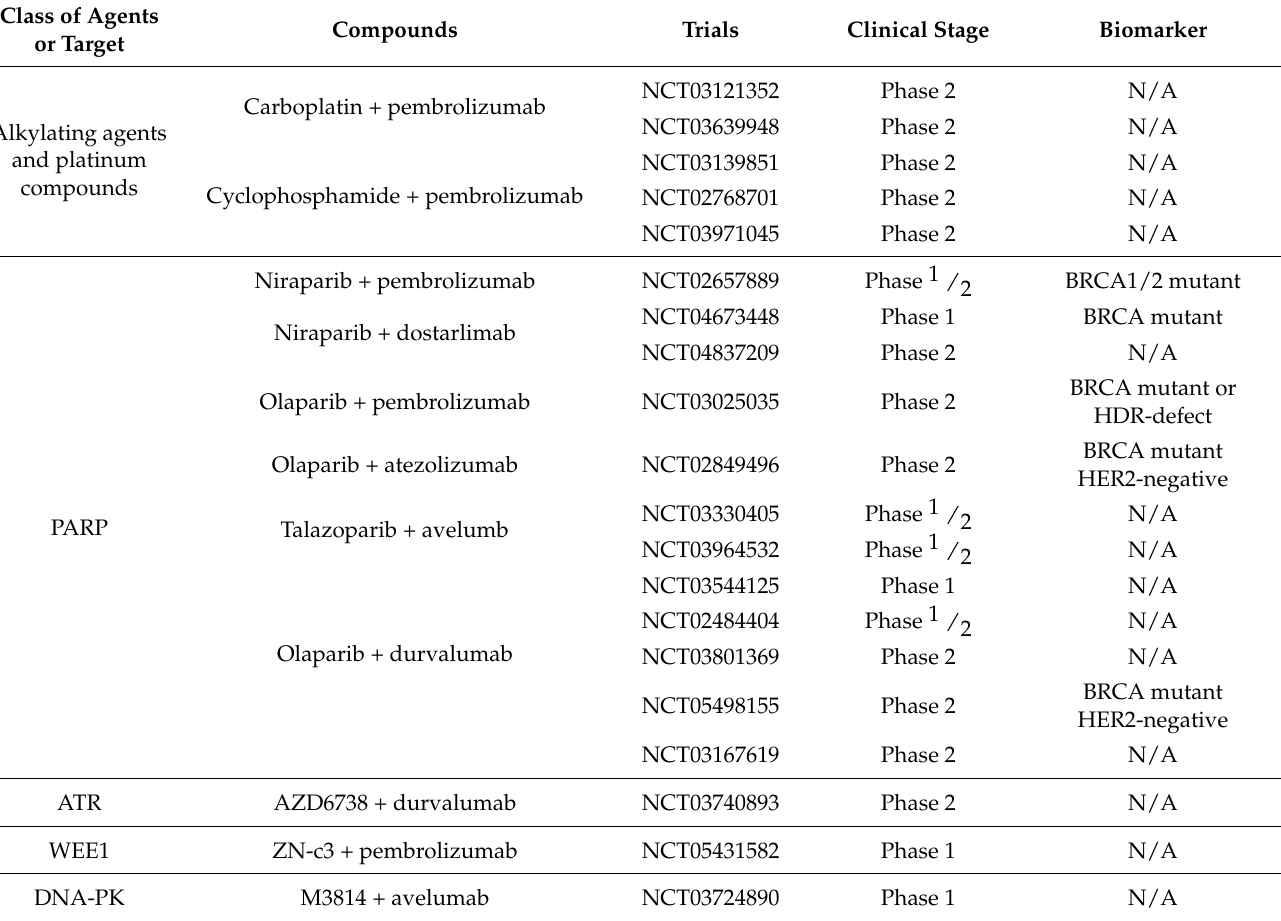
Table 2. Combination strategies of ICB with agents targeting RS in breast cancer. Compounds Trials Clinical Stage